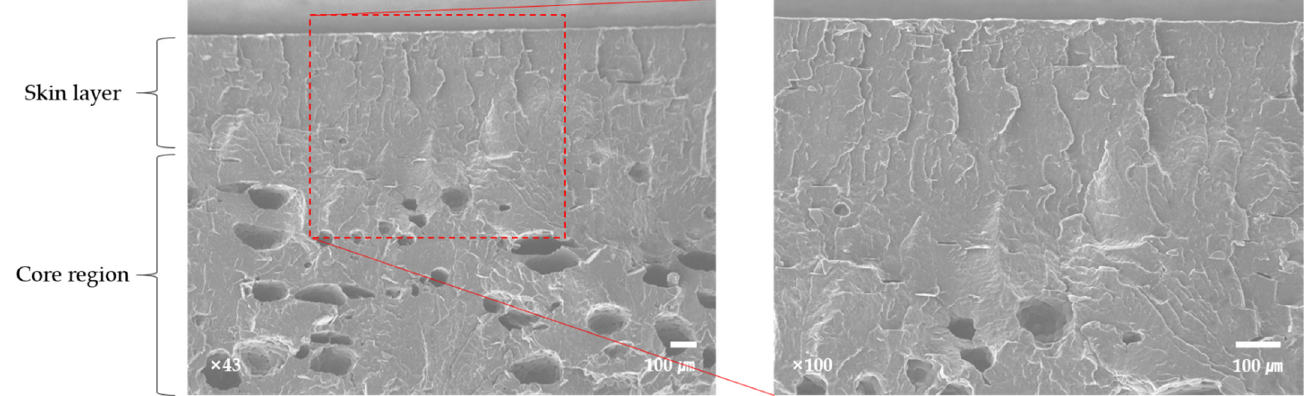
Figure 6. SEM image of aluminum 3% FIM.